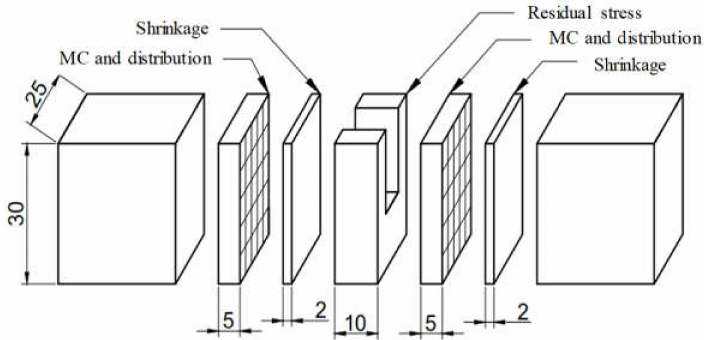
Figure 2. Sketch map of sample cutting.